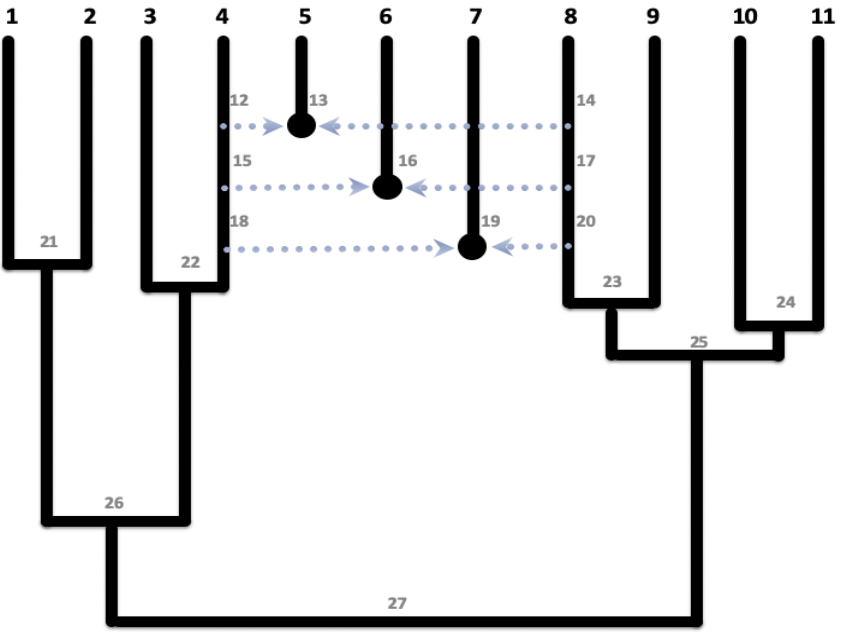
Figure 4. Sunflower network regraphed from [33]. Species on the tip from the leftmost (labeled with the number 1) to the rightmost (labeled with the number 1) are 1. praecox, 2. debilis, 3. neglectus, 4. petiolaris, 5. anomalus, 6. deserticola, 7. paradoxus, 8. annuus, 9. argophyllus, 10. bolanderi, and 11. exilis, where deserticola, anomalus, and paradoxus are hybrids from petiolaris and annuus. The eNewick format is ( 1 : 0, (( 2 : 0.84, (( 3 : 0.23,4 : 0.23 ) 16 : 0.55, ( 5 : 0.32, ( 6 : 0.15, ( 7 : 0.15 ) 13 ) 12 : 0.18 : 0.16 ) 17 : 0.45 ) 20 : 0.06 ) 21 : 0.1, ((( 13,8 : 0.15 : 0.35 ) 14 : 0.2,9 : 0.35 ) 18, ( 10 : 0.16,11 : 0.16 ) 15 ) 19 : 0.43 ) 22 : 0.06 ) 23 : 0.